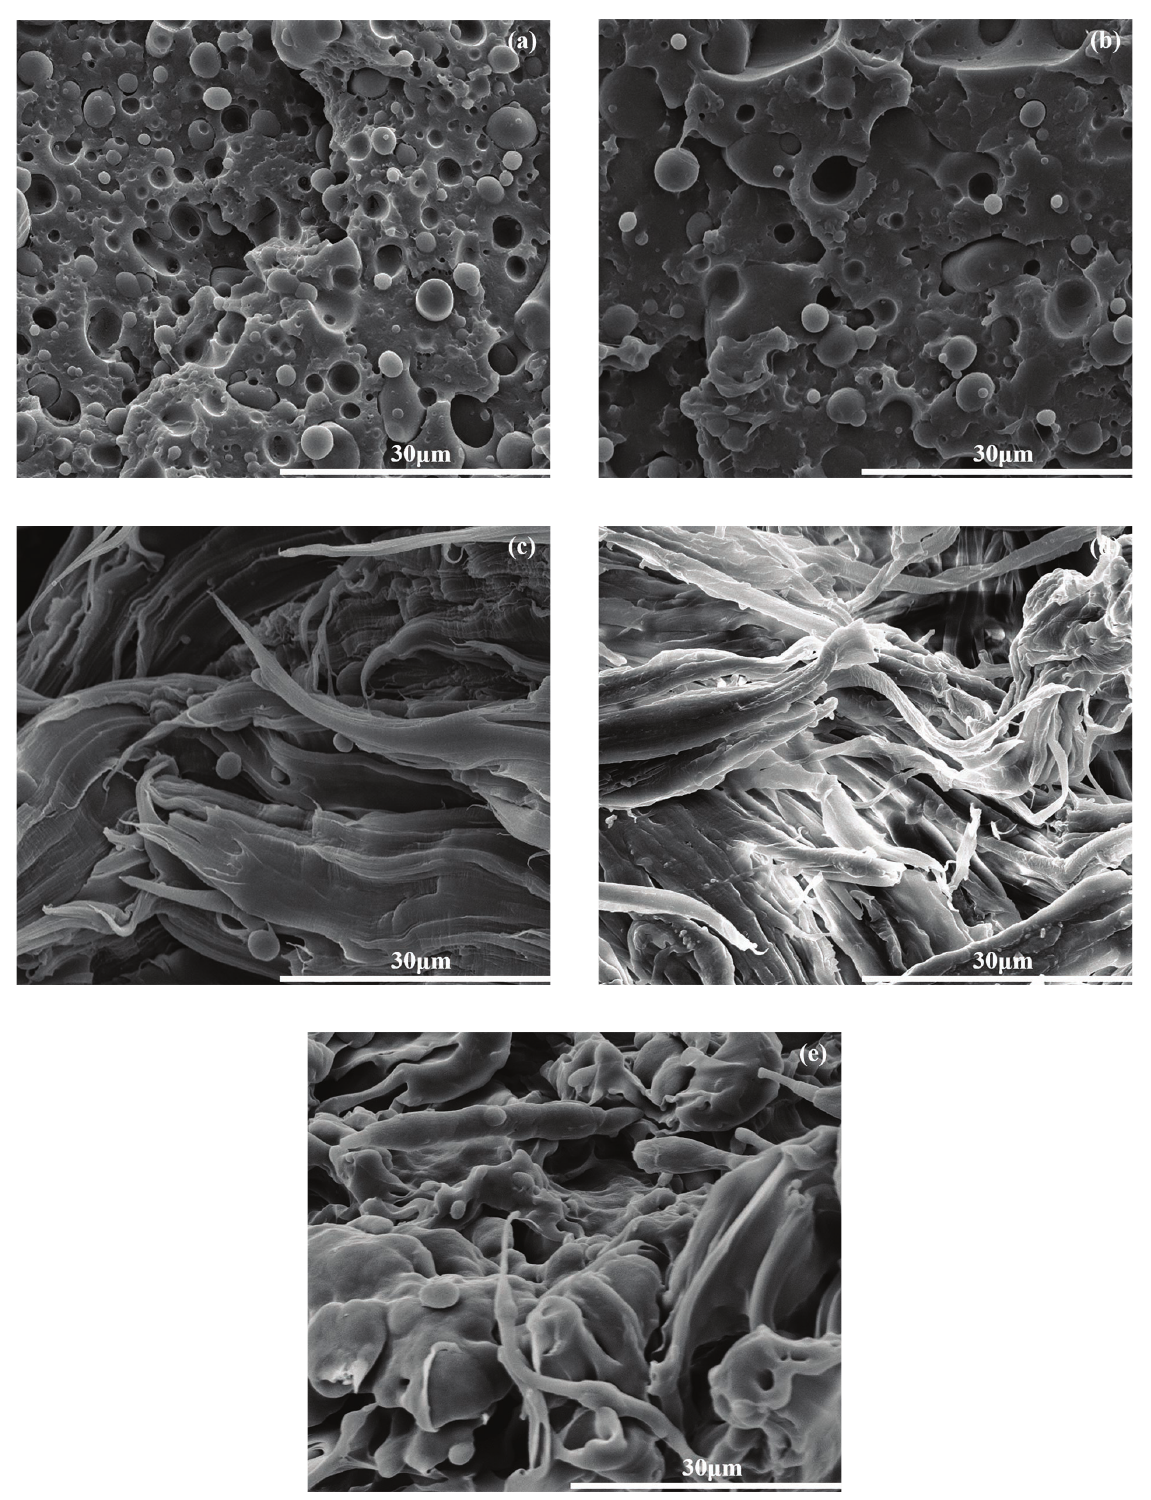
Figure 11: SEM images of the tensile fracture surface morphology of the PLA/PBAT blends with different content of ETBP: (a) neat, (b) 0.5 phr, (c) 1.0 phr, (d) 3.0 phr and (e) 5.0